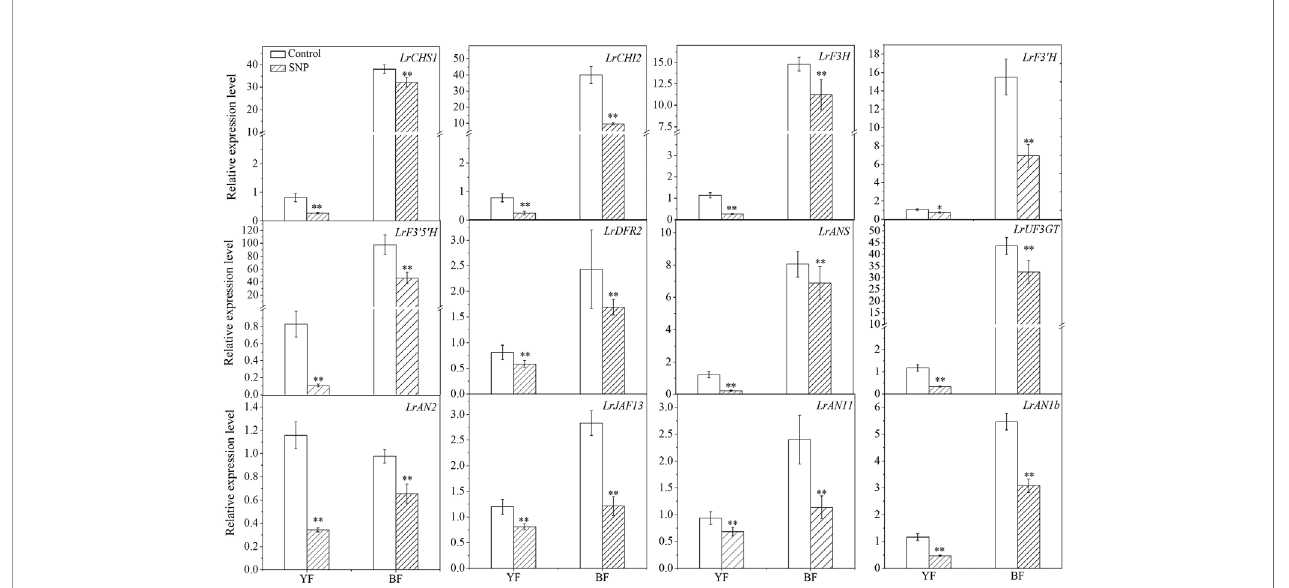
FIGURE 8 | Effect of exogenous SNP application on anthocyanin biosynthesis-related gene expression in Lycium fruits. Transcript levels of LrCHS1 , LrCHI2 , LrF3H , LrF3 ′ H , LrF3 ′ 5 ′ H , LrDFR2 , LrANS , LrUF3GT LrAN2 , LrJAF13 , LrAN11 , and LrAN1b were shown. The gene expression differences between the two species were compared using YF (sprayed with ddH 2 O) as the control for calculating the relative expression levels of the indicated genes. The data show the means ± SDs (n = 3). The asterisks on the bars for the same species indicate signi fi cant differences between the treatments. “ * ” indicates p < 0.05, and “ ** ” indicates p < 0.01.